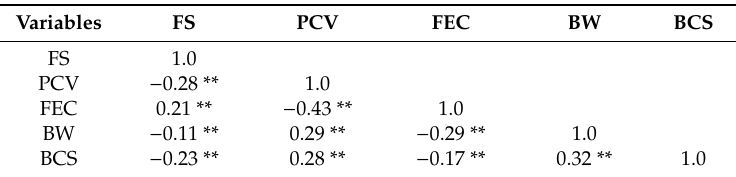
Table 7. Spearman Rank’s Correlations between animal-based welfare indicators and Fecal Egg Count (FEC) and Packed Cell Volume